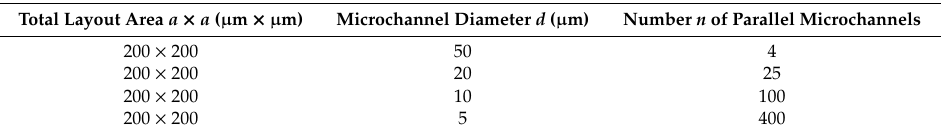
Table 1. Layout data in terms of diameter, number of microchannels, and elementary square